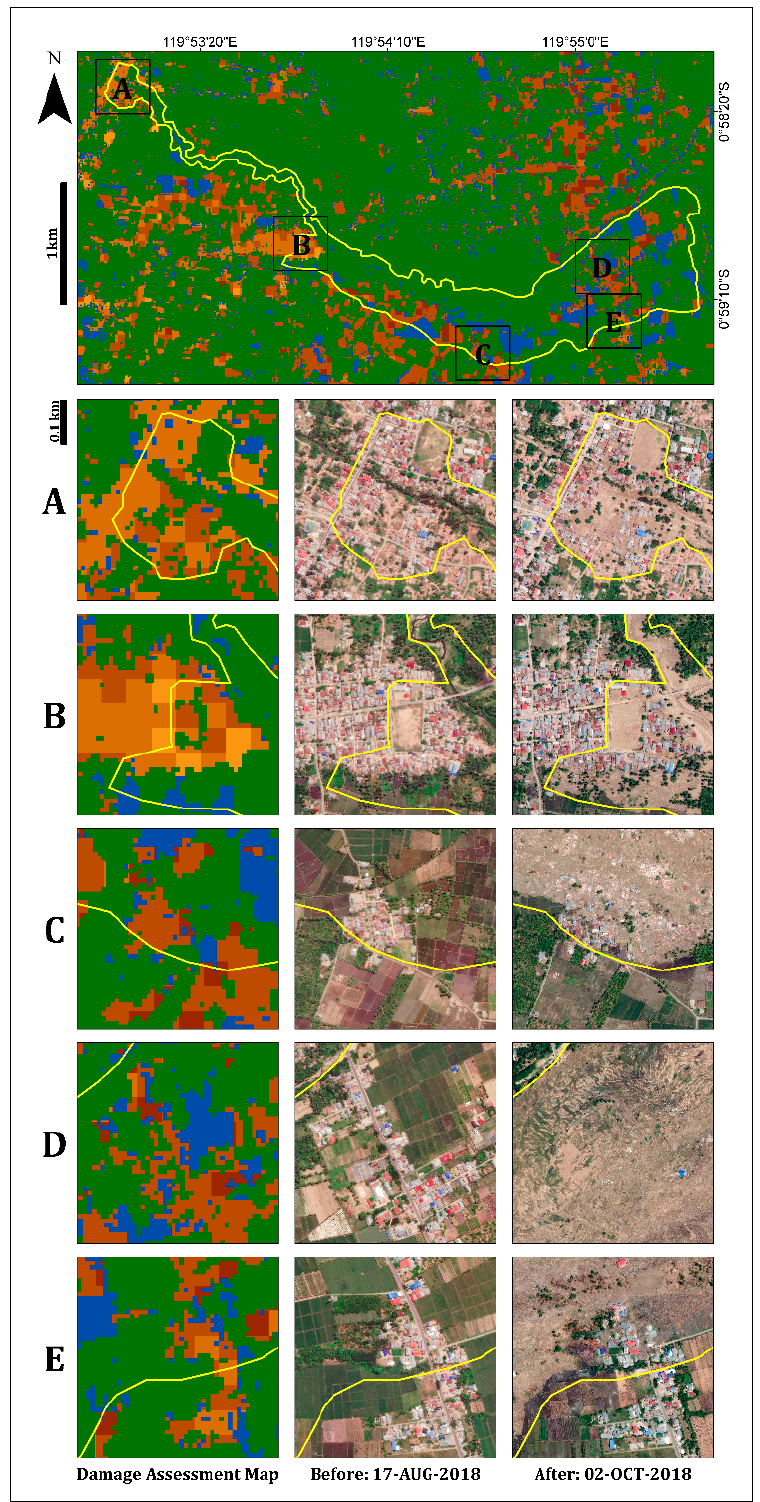
Figure 9. Zoomed in damaged built-up areas in Jono Oge village (subfigures A – E ) resulting from the second hazards, liquefication and flow slide. Pre-event optical image (17 August 2018), post-event optical image (2 October 2018), and the damage assessment map (see legend in Figure